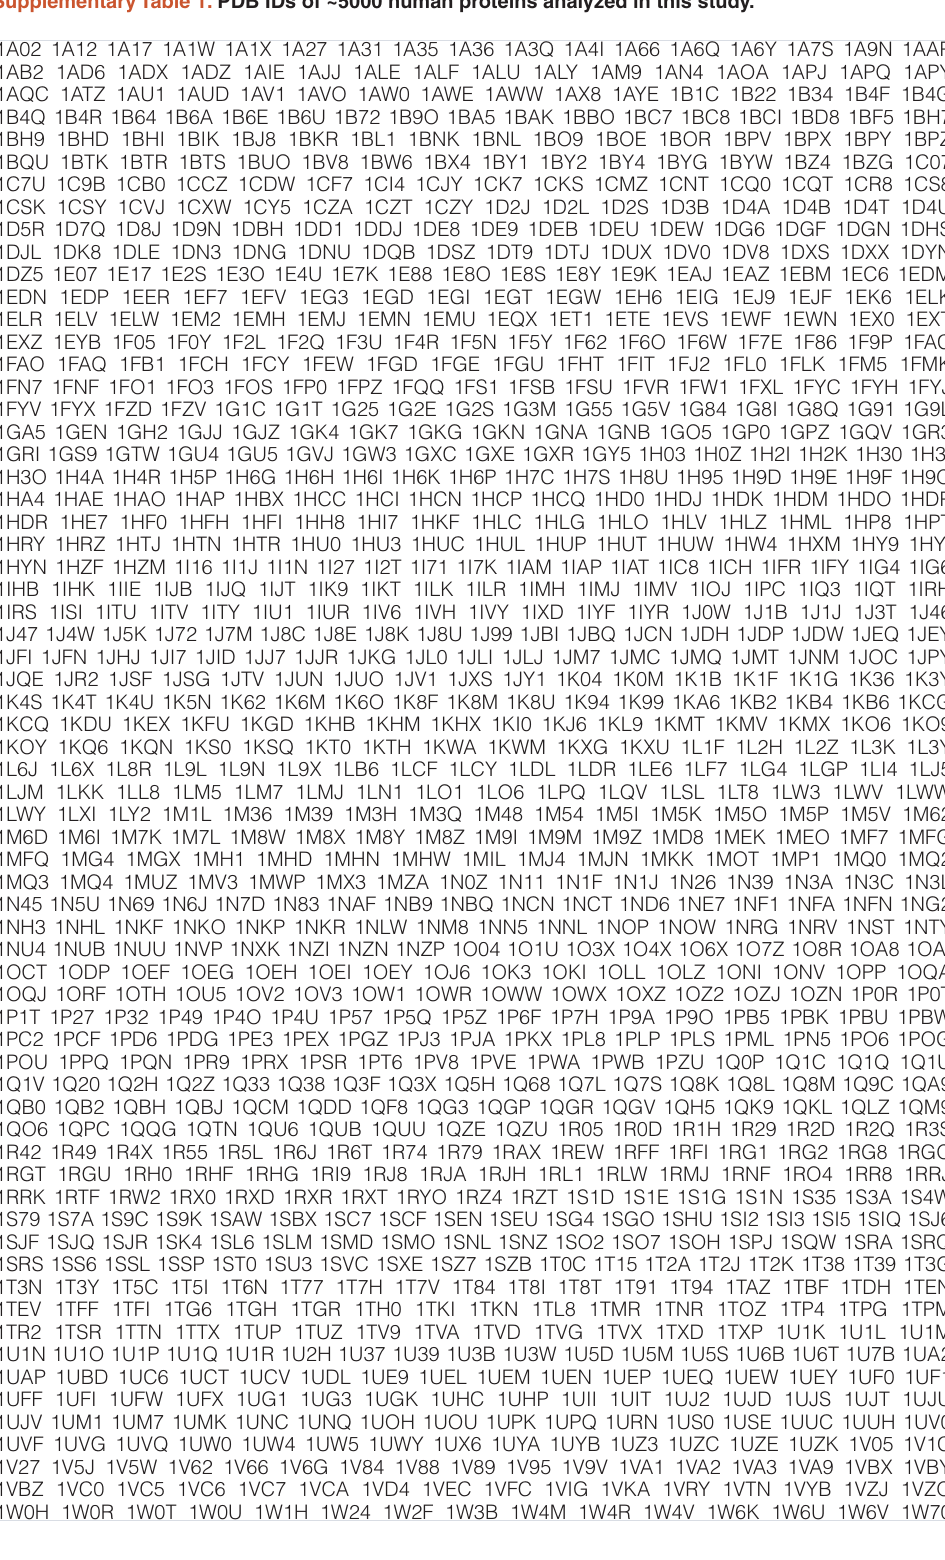
Supplementary Table 1. PDB IDs of ~5000 human proteins analyzed in this